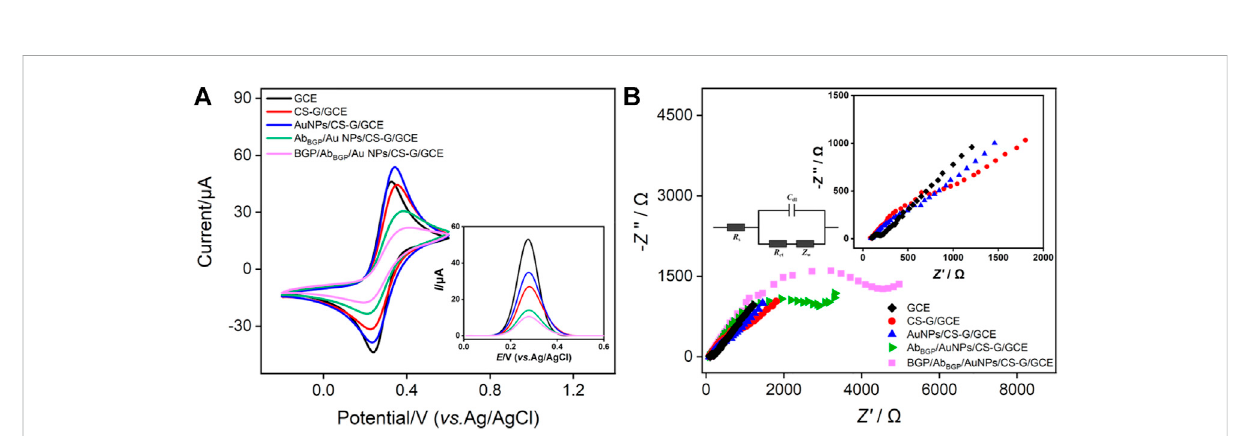
CV (A) and EIS (B) curves obtained on different electrodes including GCE, CS-G/GCE, AuNPs/CS-G/GCE, Ab BGP /AuNPs/CS-G/GCE, and BGP/ Ab BGP /AuNPs/CS-G/GCE. The electrolyte solution is Fe(CN) 6 3-/4- (2.5 mM) containing 0.1 M KCl. Inset in (A) includes the corresponding DPV curves. Insets in (B) are equivalent circuits of detection (left) and the enlarged view of the EIS curves at the high frequency